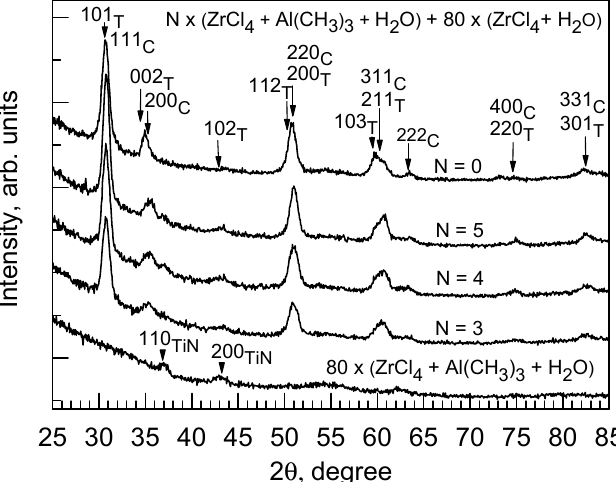
Figure 6. Grazing incidence X-ray diffraction patterns from asymmetrically deposited Zr x Al y O z -ZrO 2 films, comprising successive pulses of ZrCl 4 , Al(CH 3 ) 3 and H 2 O, applied N times (N indicated by labels) directly on TiN bottom electrode surface and followed by 80 ZrO 2 deposition cycles. Labels also indicate the Miller indexes attributable to either cubic or tetragonal phases of ZrO 2 , as well as those of the cubic TiN substrate layer. The bottom pattern, enclosed for comparison, represents that from X-ray amorphous reference film grown with 80 ALD cycles including successive pulses of ZrCl 4 , Al(CH 3 ) 3 and H 2 O.